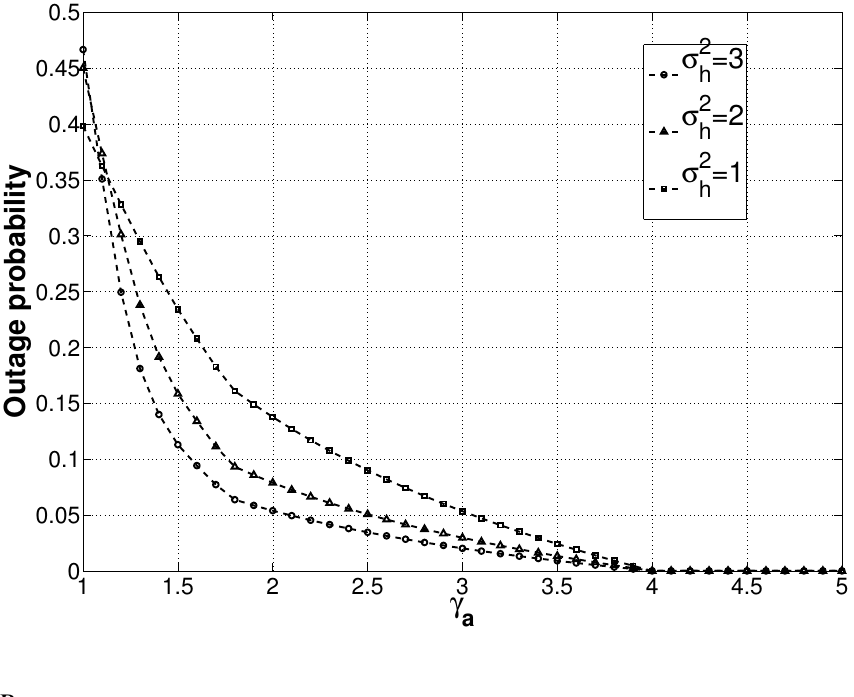
Figure 4. Outage probability curve. The horizontal axis shows the power available at the transmitter. The power available at the transmitter is assumed to be always greater than or > 1 . With the increasing channel variance, σ equal to the signal power, hence γ a outage